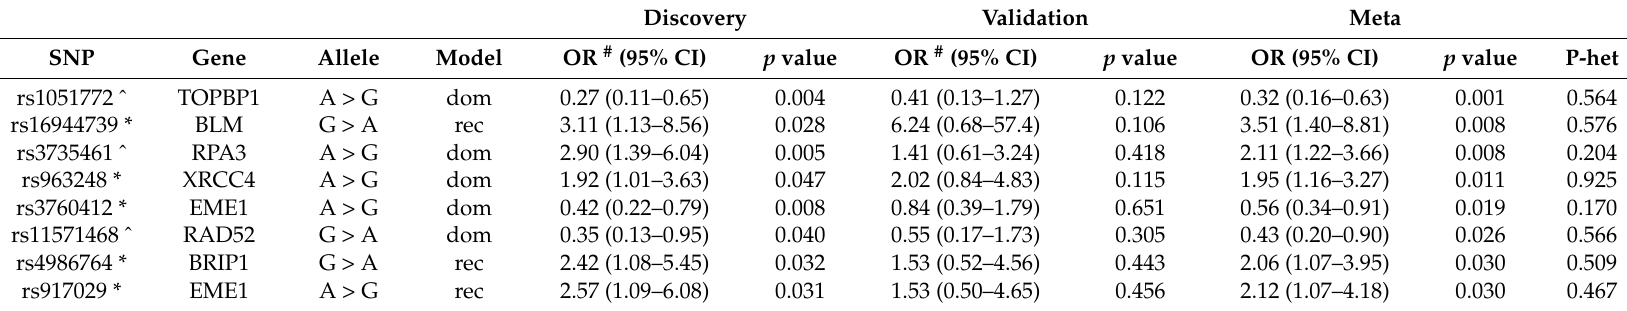
Table 3. Eight DNA double-strand break repair pathway related SNPs with same trend effects on radiation pneumonitis across two analytical